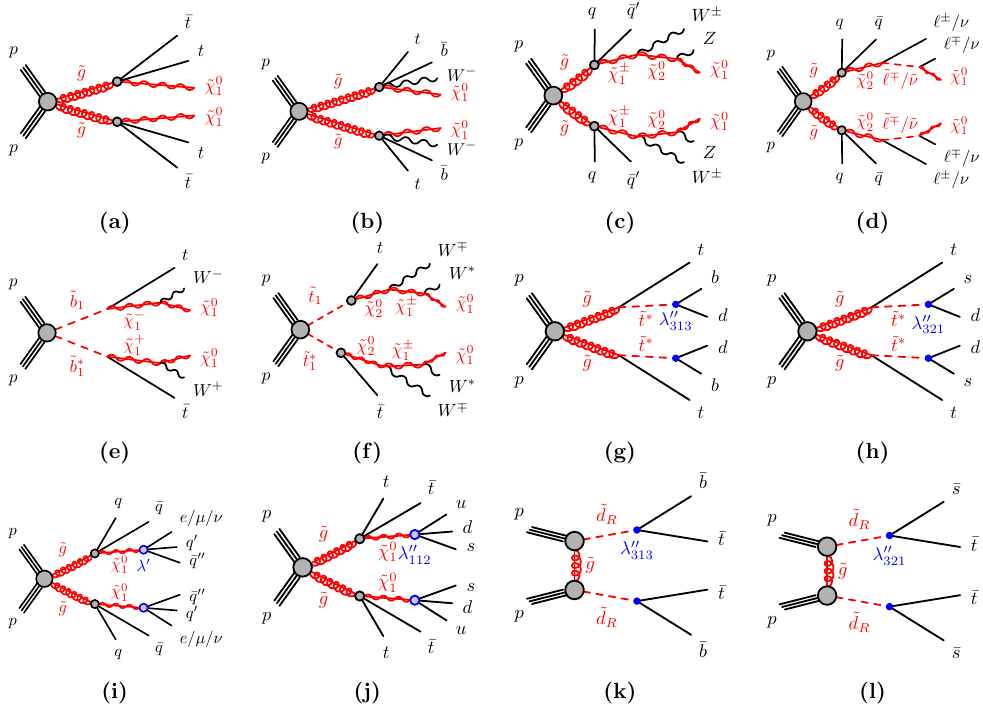
Figure 1. RPC SUSY processes featuring gluino ((a), (b), (c), (d)) or third-generation squark ((e), (f)) pair production studied in this analysis. RPV SUSY models considered are gluino pair production ((g), (h), (i), (j)) and t-channel production of down squark-rights ((k), (l)) which decay via baryon- or lepton-number violating couplings (cid:21) 00 and (cid:21) 0 respectively. In the diagrams, q (cid:17) u; d; c; s and ‘ (cid:17) e; (cid:22); (cid:28) . In (cid:12)gure 1d, ~ ‘ (cid:17) ~ e; ~ (cid:22); ~ (cid:28) and ~ (cid:23) (cid:17) ~ (cid:23) e ; ~ (cid:23) (cid:22) ; ~ (cid:23) (cid:28) . In (cid:12)gure 1f, the W (cid:3) labels indicate largely o(cid:11)-shell W bosons | the mass di(cid:11)erence between ~ (cid:31) (cid:6) 1 and ~ (cid:31) 0 1 is around 1 GeV. (cid:21) 00 ) couplings, the exclusion limits set for these scenarios also hold for non-zero (cid:21) 00 321